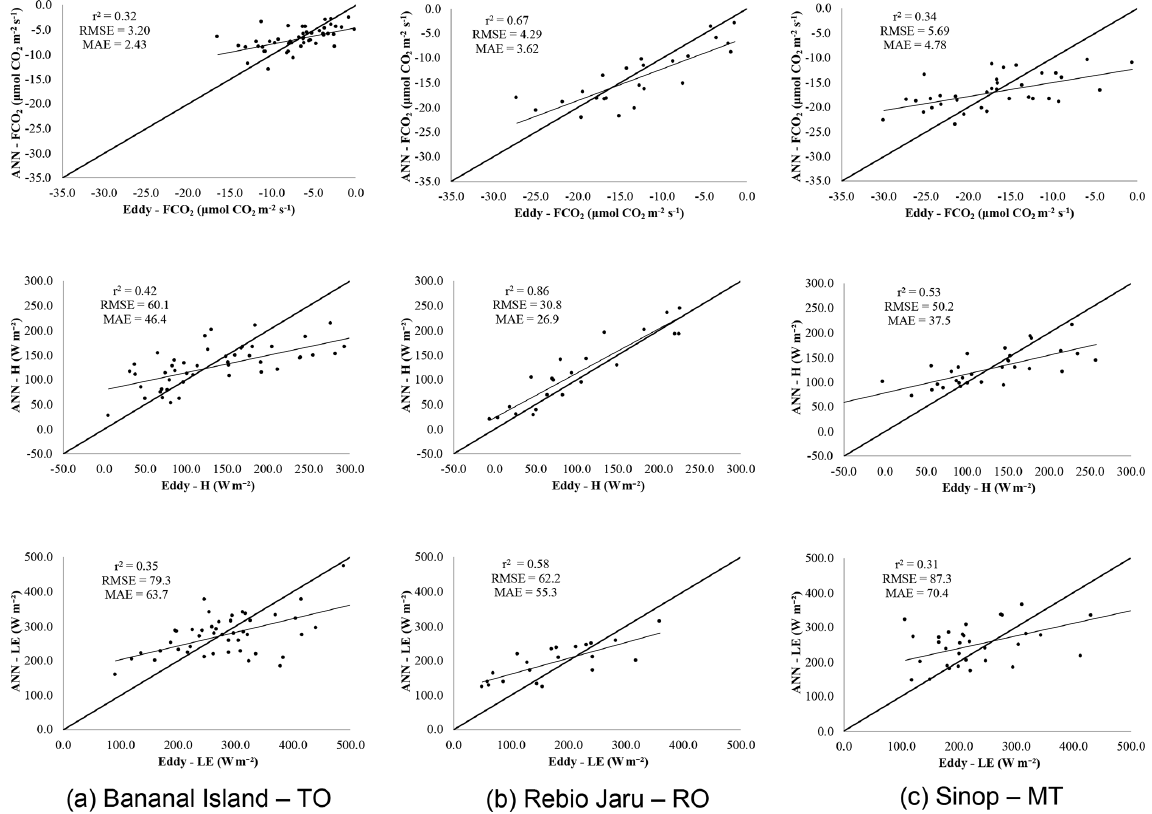
Figure 2. FCO 2 (µmolCO 2 m − 2 s − 1 ), H (Wm − 2 ), and LE (Wm − 2 ) calculated from flux tower data through eddy covariance ( x axis) versus modeled by ANNs ( y axis), with r 2 , RMSE, and MAE. The 1 : 1 straight line (thick) and the linear fit (thin) are also represented for the three study sites.